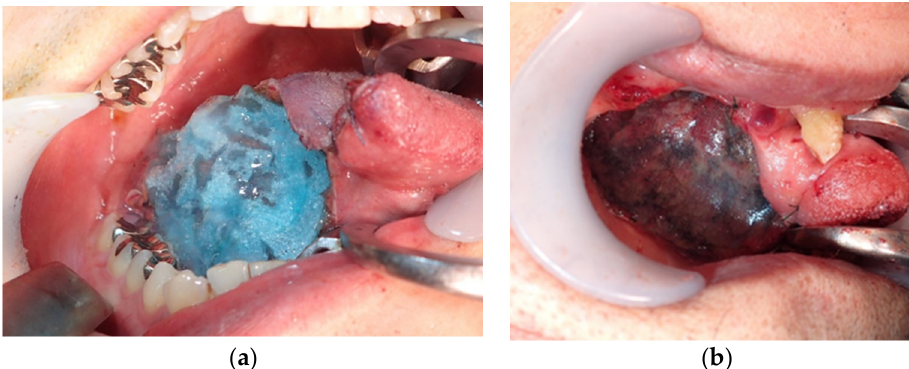
Figure 1. Polyglycolic acid (PGA) sheet attached to the wound ( a ); the fibrin glue was sprayed onto the PGA sheet ( b ).